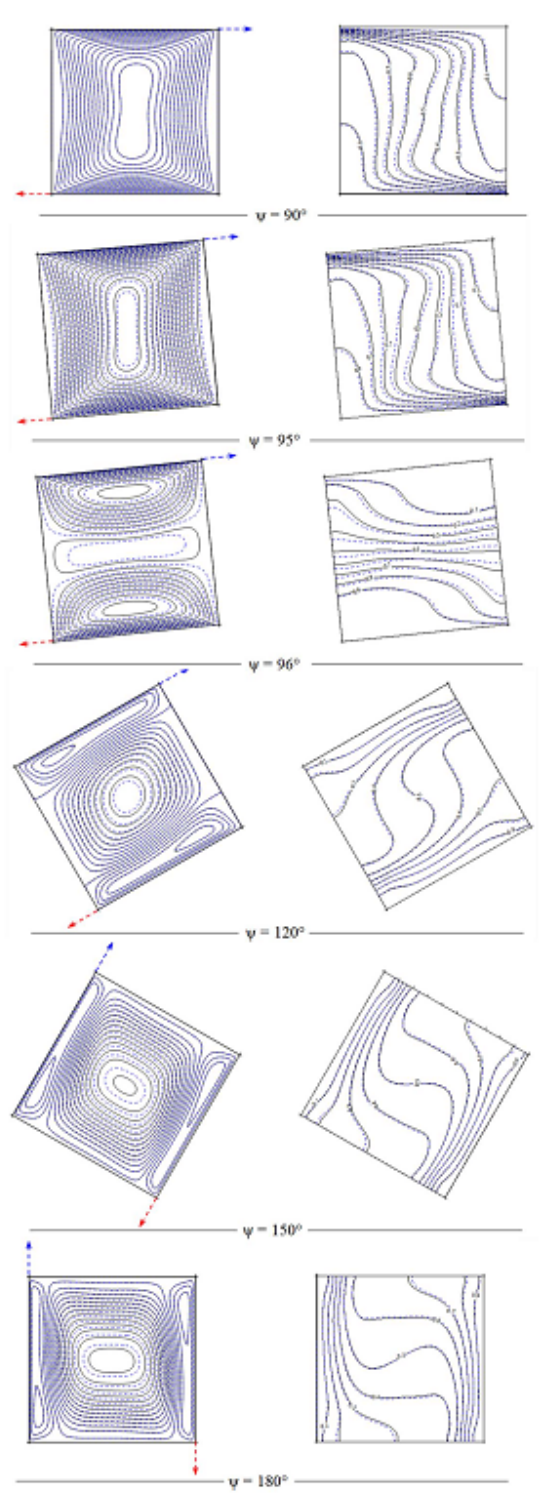
Figure 6: Streamlines (a) and Isotherm plots (b) of the nanofluids for different values of the inclination angle. ϕ = 0.10 , Ri = 100 , [ —- Cu-water, — Ag-water